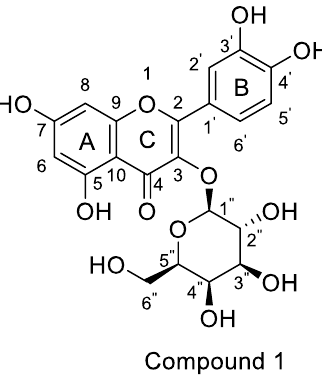
Figure 1. Structure of hyperoside.